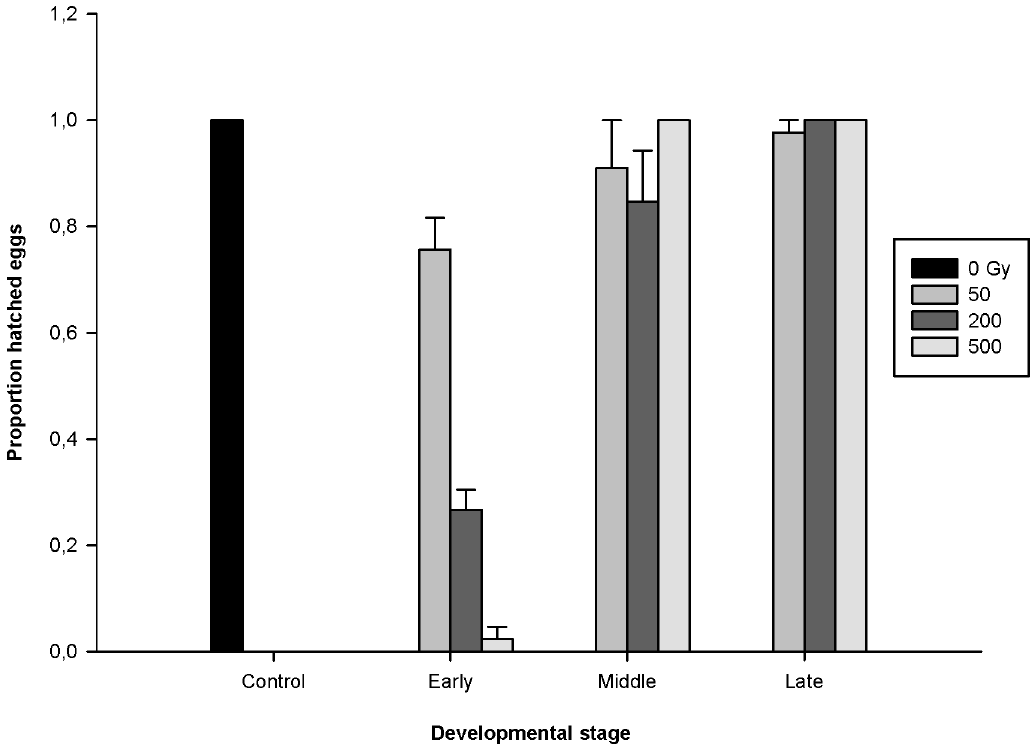
Figure 2. Proportion of hatched eggs of M. cf. tardigradum eggs exposed to 50, 200 and 500 Gy of gamma radiation, during different developmental stages. Developmental stages are denoted as Early (E), Middle (M) and Late (L). See main text and Fig. 1 for more details on developmental stages. Each bar is based on three replicate samples, each with 15 eggs, and error bars denote standard error of the mean. Estimated mean values (SD): Control, 1.0 (0); E50, 0.76 (0.10); E200, 0.27 (0.067); E500, 0.022 (0.038); M50, 0.91 (0.15); M200, 0.84 (0.17); M500, 1.0 (0); L50, 0.98 (0.038); L200, 1.0 (0); L500, 1.0 (0).